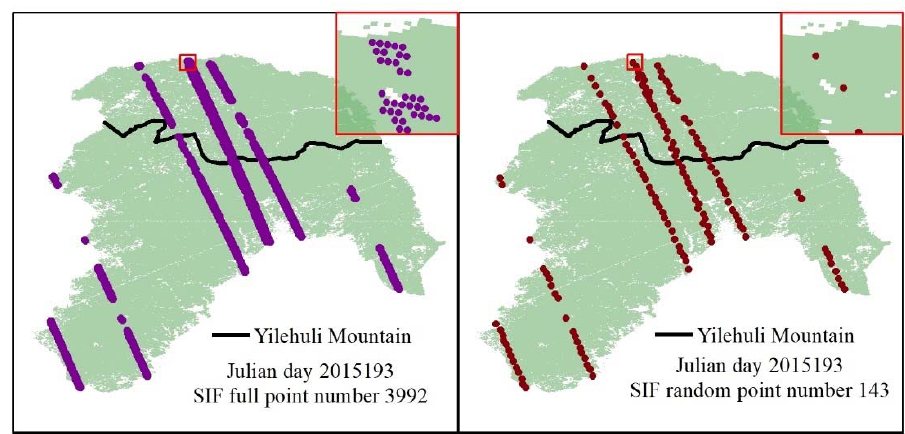
Figure 4. Example of random point extraction. Figures on the left and right show the full SIF points and the random points. The red rectangle insets in the top ‐ right corners are the enlarged versions of the small, red rectangles in the figures.